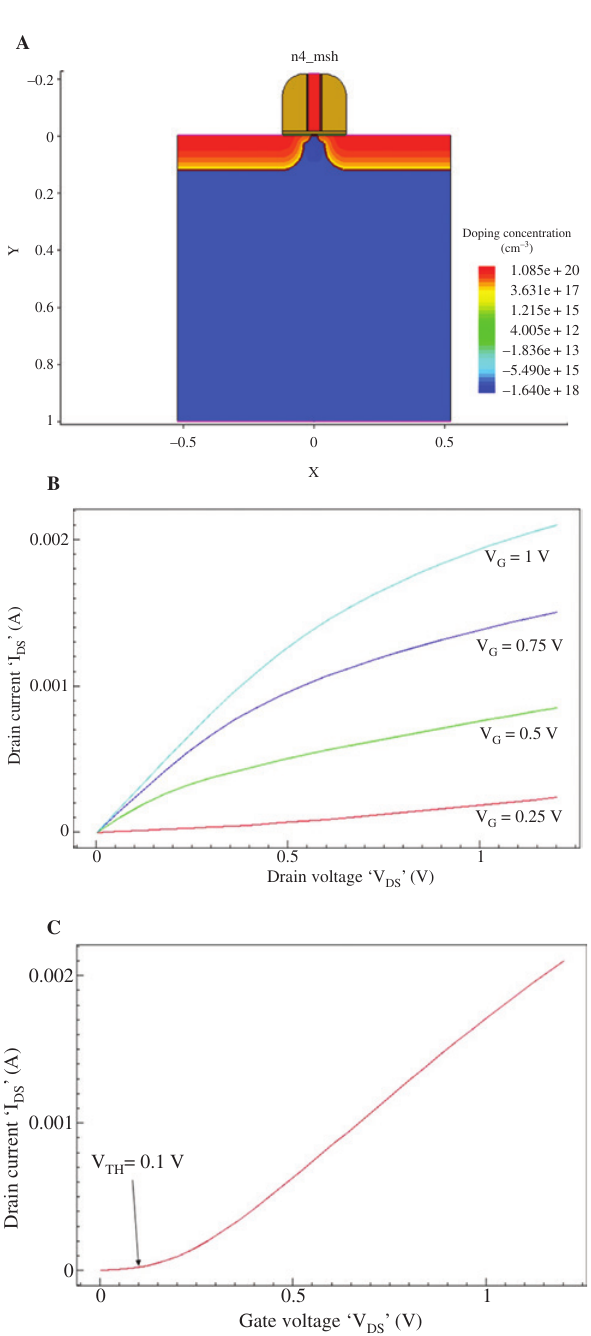
Figure 8: (A) III–V GaN nanostructure (10 nm thickness)